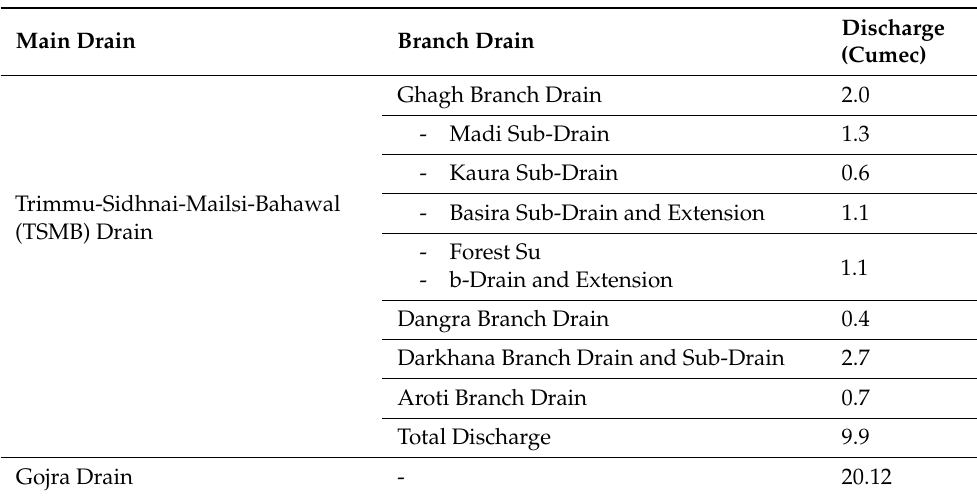
Table 3. Data on Rehabilitated Surface Drains (Source: [30]).